Question: In a single sentence, describe what this figure presents.
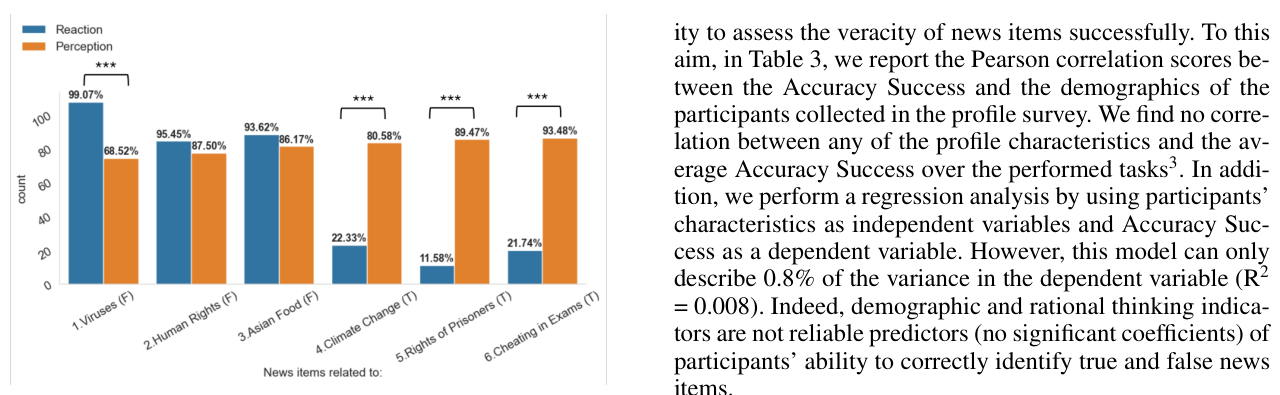
Answer: Accuracy Success distribution for the six differ- ent news items during the Reaction and Perception phases. Every pair of bars represents the topic of the news item along with its veracity within brackets (“T” stands for a true news item, whereas “F” stands for a false news item). ***: p-value < 0.001. There is no statistically significant differ- ence between accuracy at Reaction and Perception phases for tasks 2 and 3.